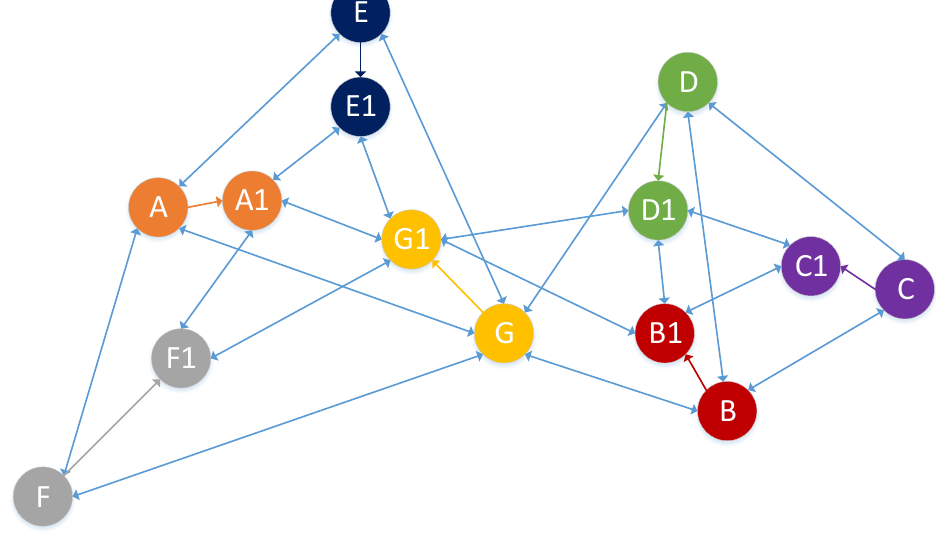
Figure 3. Graphic representation of Spatio-temporal relationship of road